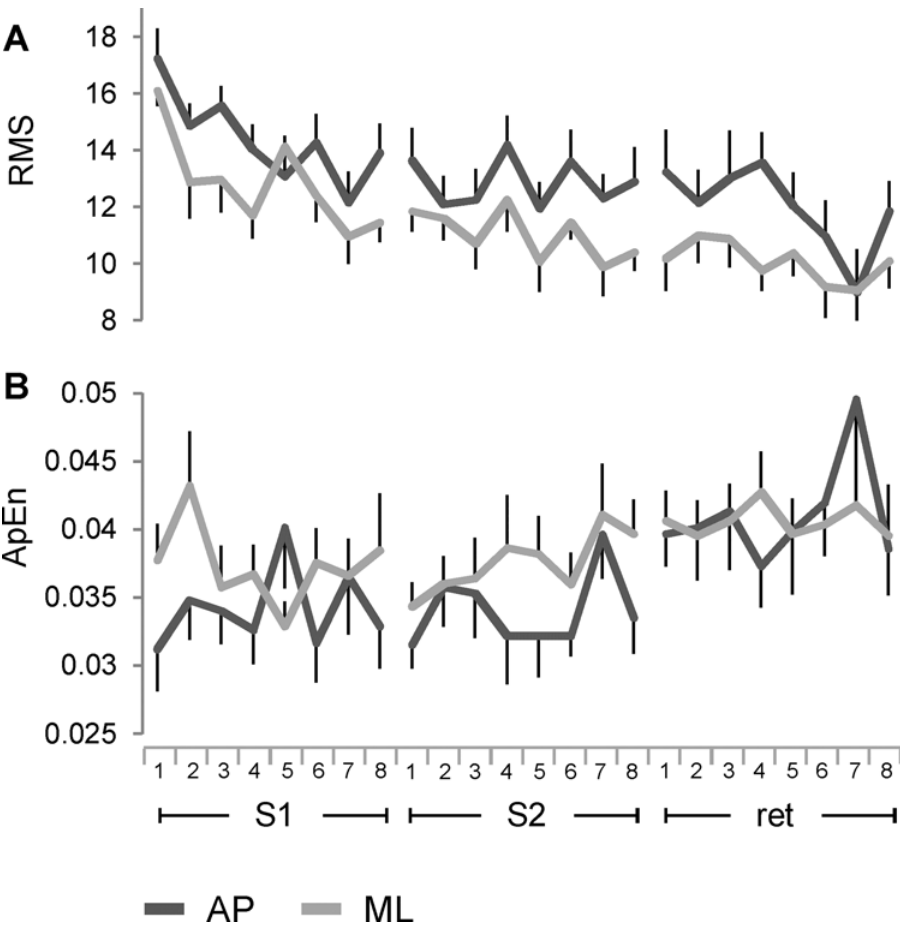
Fig 5. Changes in variability along AP and ML directions across the time course of learning. Root Mean Square (A) and Approximate entropy (B) computed from the time series of the unit normal vector along AP and ML directions. Symbols, units in A and abbreviations as in Figs 2 and